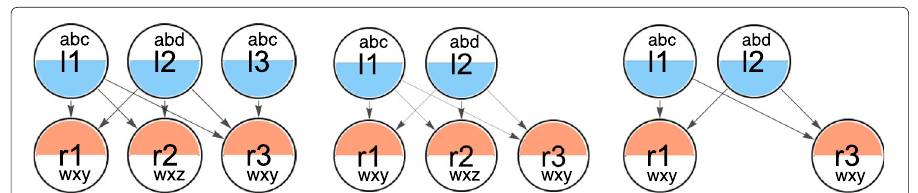
Fig. 2 The two 2-2 BHA-cores in bi-concepts of Example 2. The leftmost part displays the whole network. In the middle we have its 2-2 BHA-core associated to the closed bi-pattern ( ab , wx ) . The rightmost part of